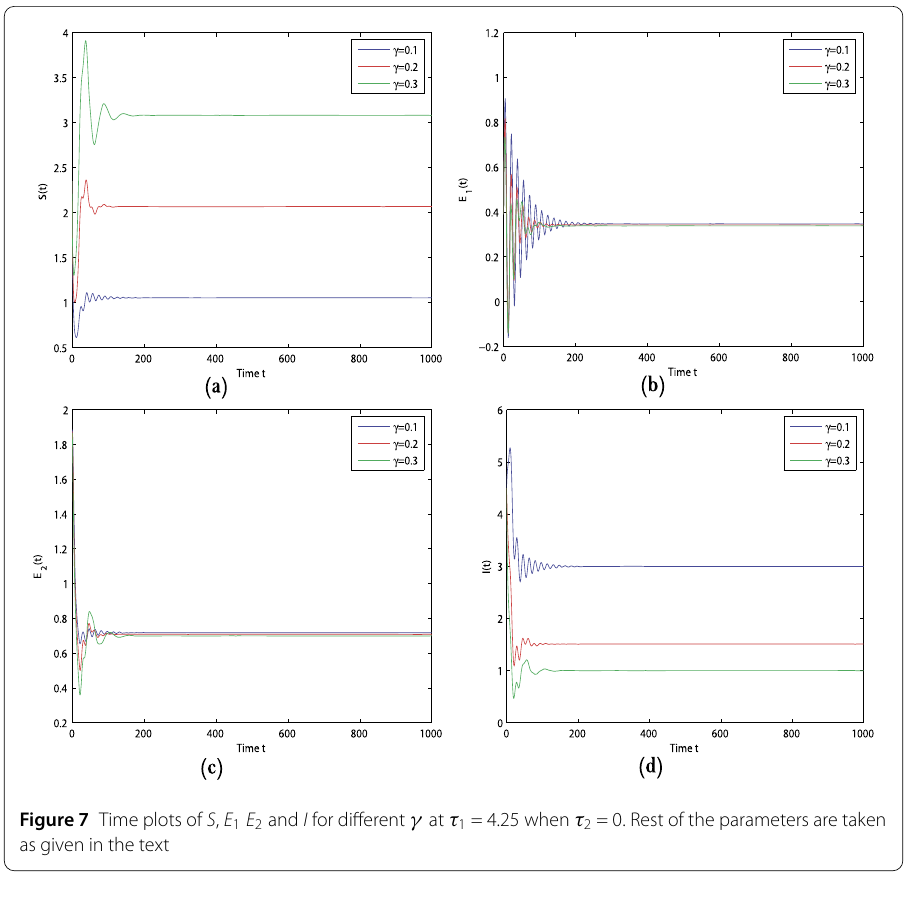
Figure 8 Dynamic behavior of system (26): projection on S – E 1 – I with τ 1 = 4.95 > τ 10 when τ 2 = 0 for different γ . Rest of the parameters are taken as given in the